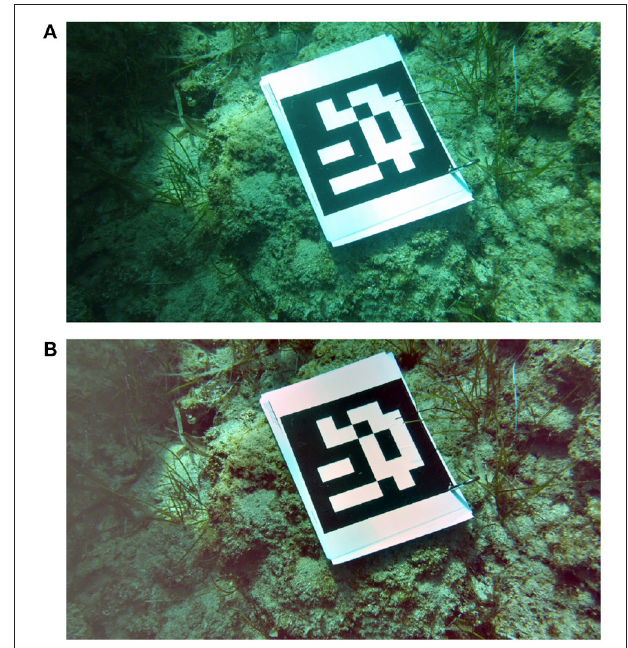
FIGURE 5 | Image with a diver holding a marker from test video 2_2 (A) processed by the ACE method (B) . Subject provided written informed consent for publication of this image.